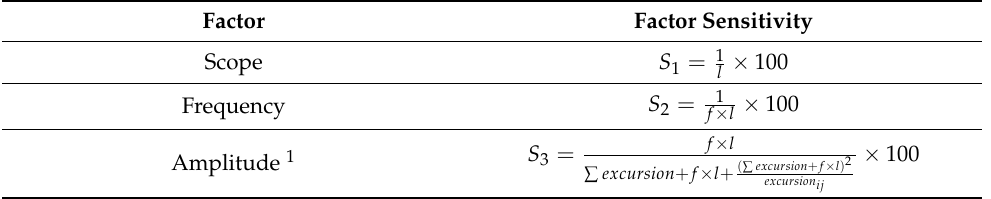
Table 2. Factor sensitivity of the Canadian Council of Ministers of Environment (CCME) Water Quality Index